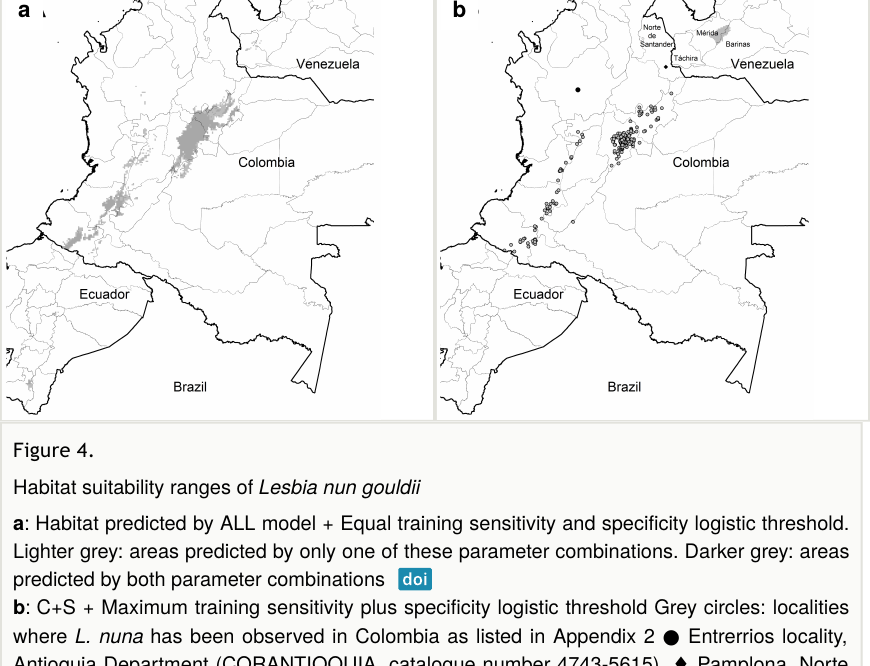
Figure 4. Habitat suitability ranges of Lesbia nun gouldii a : Habitat predicted by ALL model + Equal training sensitivity and speci fi city logistic threshold. Lighter grey: areas predicted by only one of these parameter combinations. Darker grey: areas predicted by both parameter combinations b : C+S + Maximum training sensitivity plus speci fi city logistic threshold Grey circles: localities where L. nuna has been observed in Colombia as listed in Appendix 2 ● Entrerrios locality, Antioquia Department (CORANTIOQUIA, catalogue number 4743-5615). ♦ Pamplona, Norte de Santander. Grey area between Mérida and Barinas States in Venezuela corresponds to the approximate extent of the Sierra